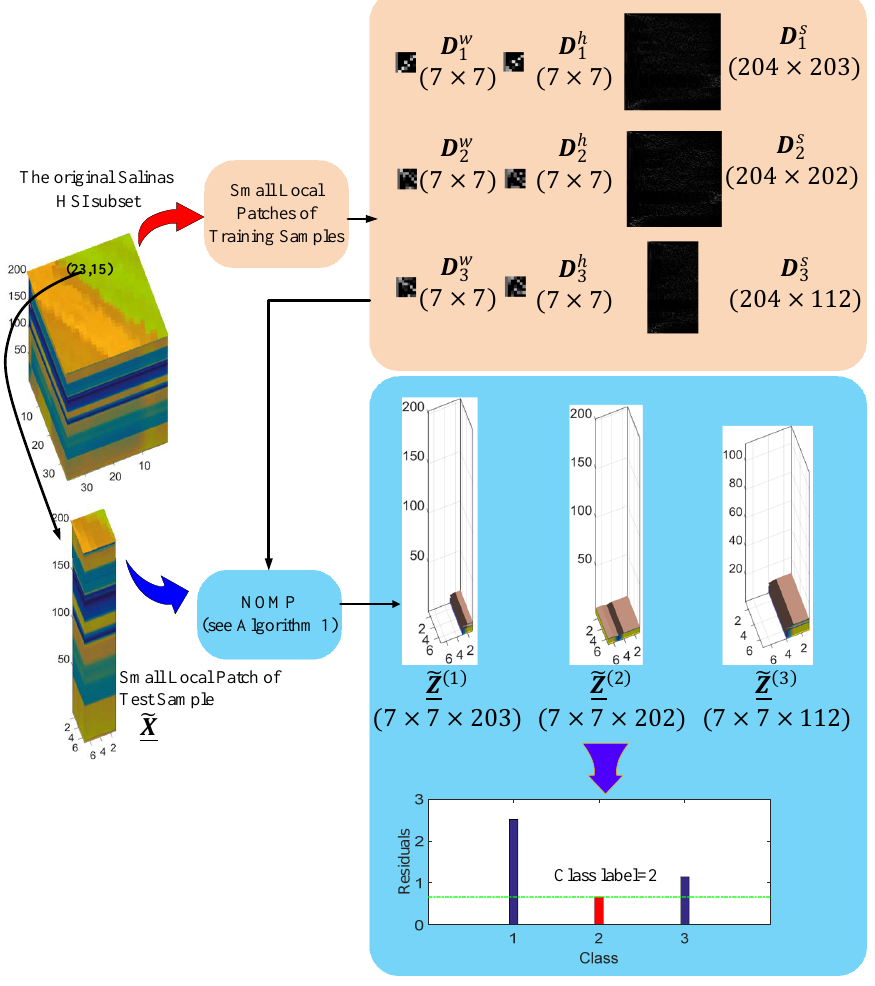
Figure 4. A synthetic example conducted on a subset of the Salinas-A